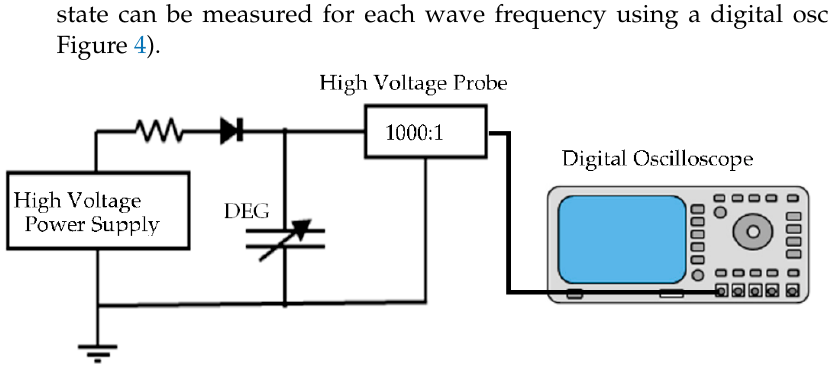
Figure 4. Voltage measurement circuit of the DEG in the contracted state.